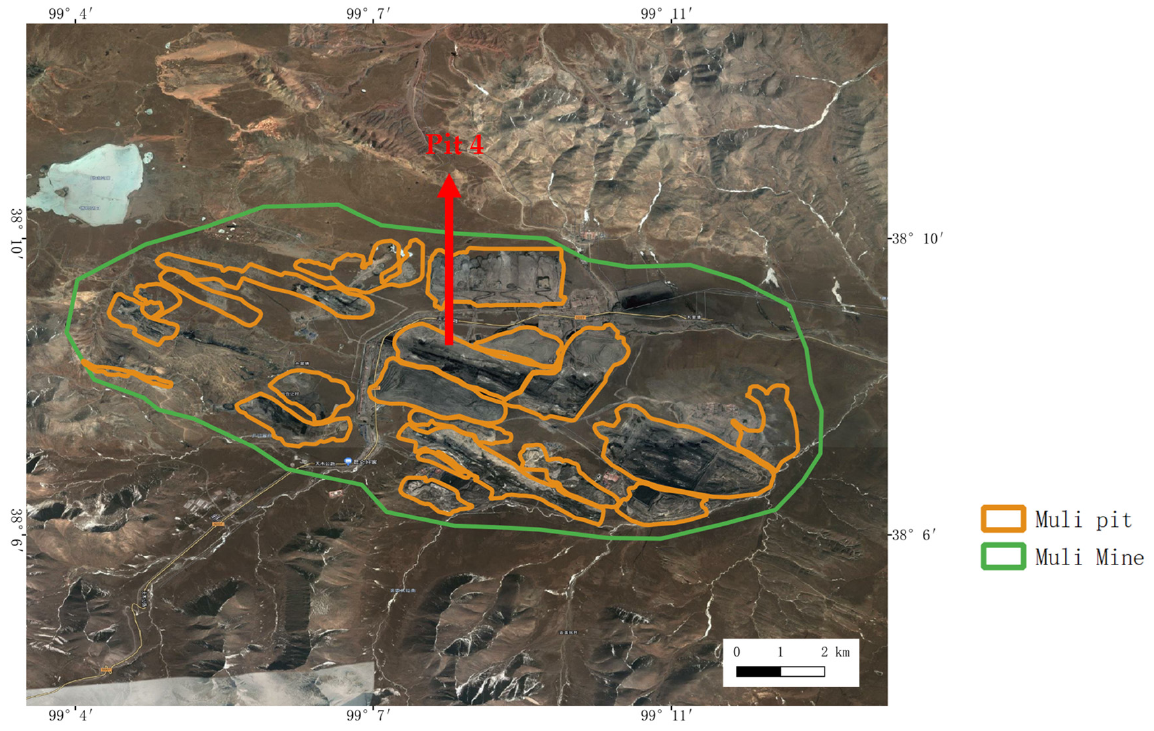
Figure 1. Location of the Muli mine area.